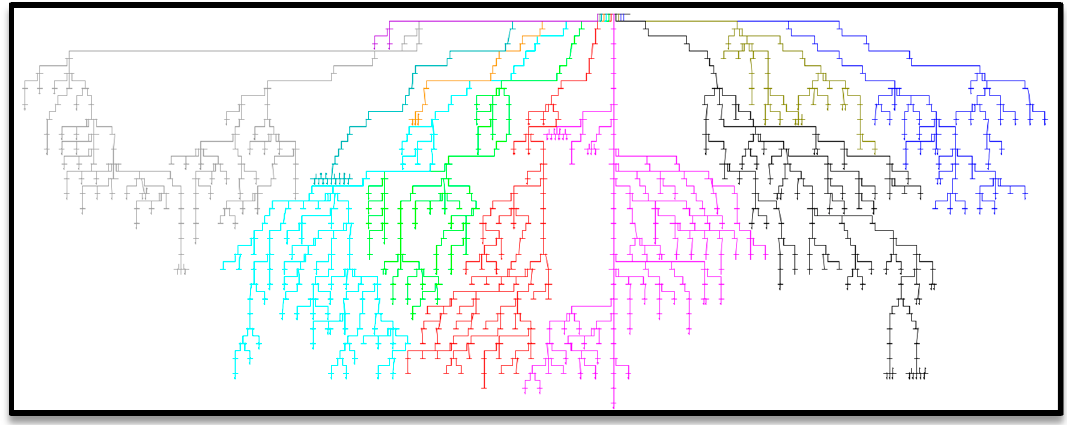
Figure A1. Network Topology.